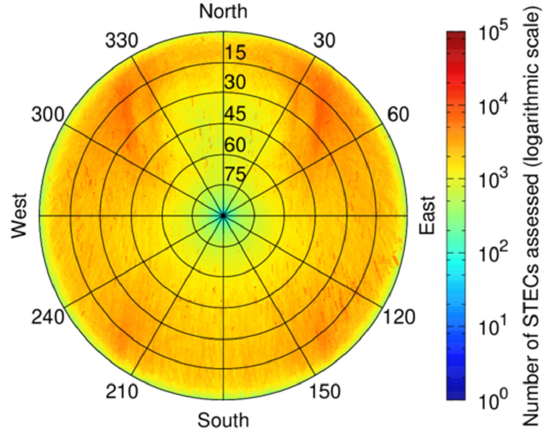
Figure 2. Sky plot with the number of STECs assessed for 1st March 2019, after accumulating all stations available in the IGS MGEX network into a single plot. The bin size is half degree of elevation and azimuth.